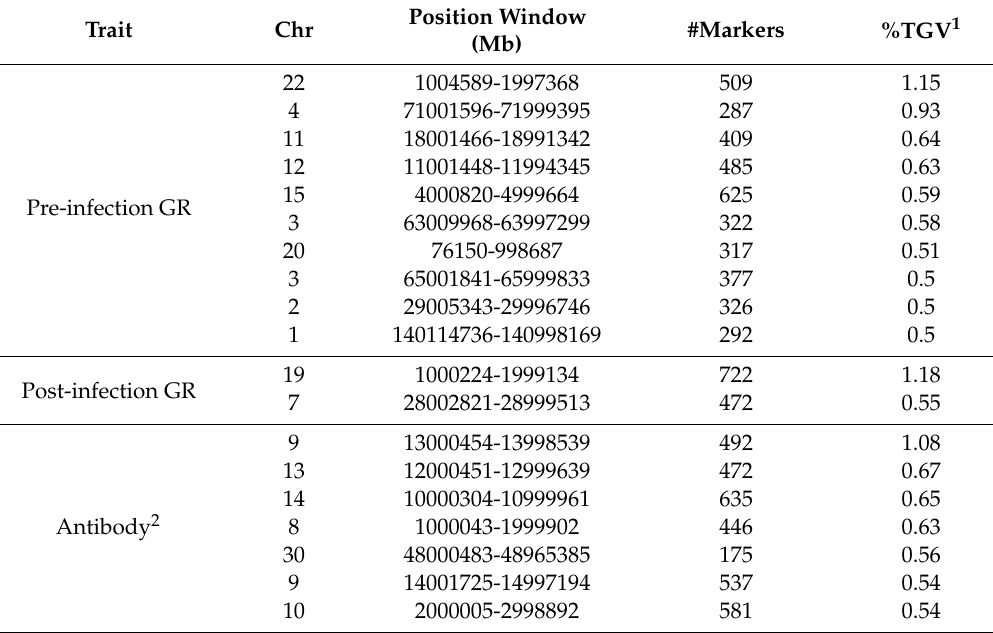
Table 5. Percentage of genetic variance explained by 1-Mb genomic regions that are associated with NDV response traits ( > 0.5% of genetic variance) based on the Bayes-B method.